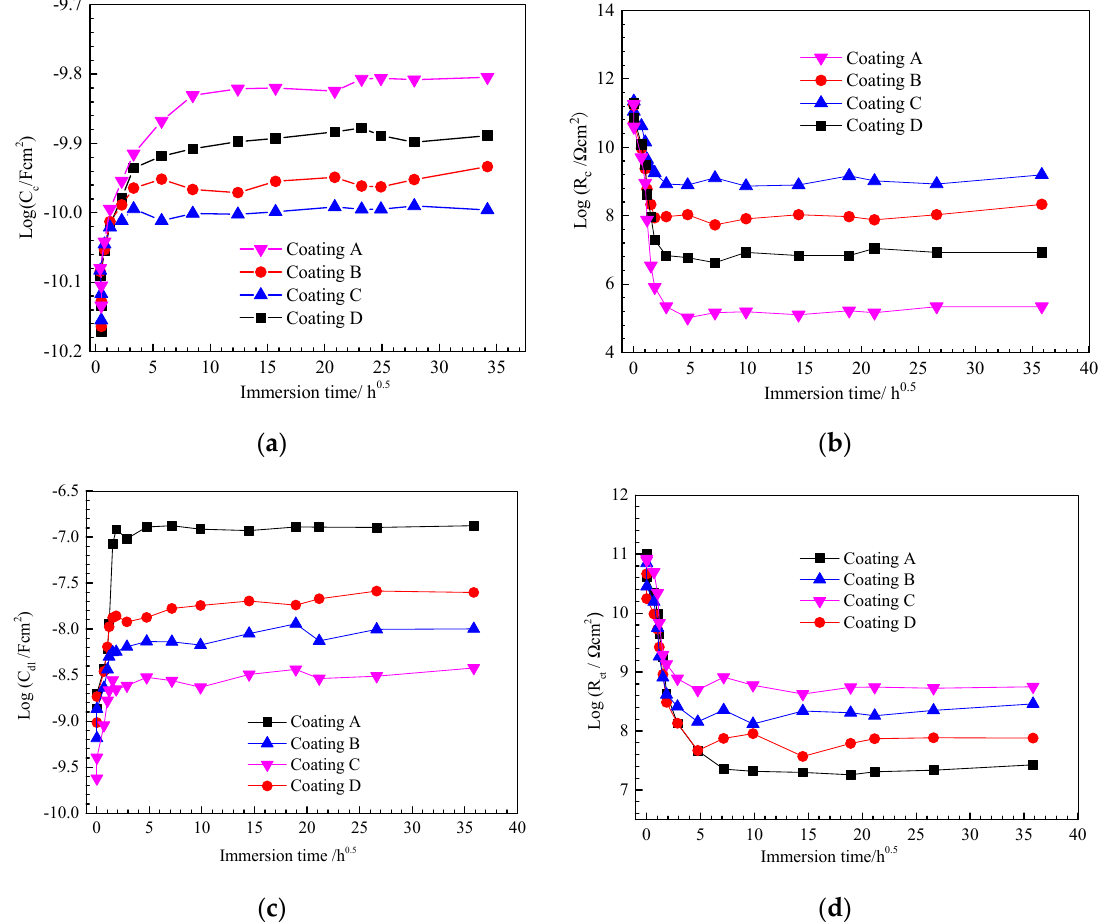
Figure 7. Evolution of the electrical parameters C c ( a ), R c ( b ), C dl ( c ) and R ct ( d ) derived from EIS data for the coatings during the immersion in 5 wt.% NaCl solution.